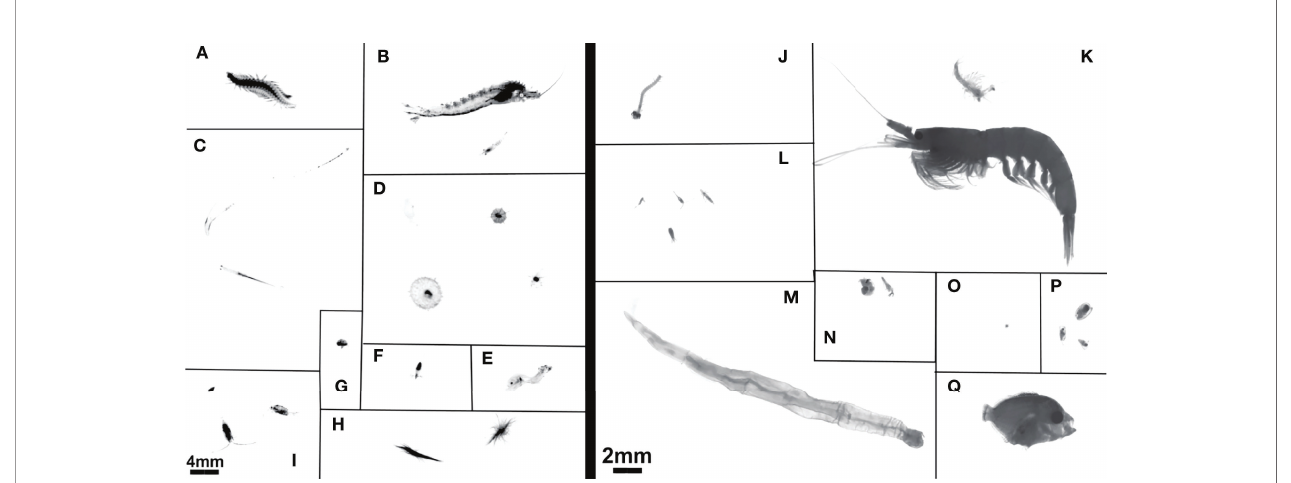
FIGURE 1 | Example images from (A – I) the UVP and (J – Q) MOCNESS. UVP images have 4mm scale bar in bottom left. MOCNESS images use 2mm scale bar in bottom right. UVP images are (A) Annelida, (B) Shrimp-like Crustacea, (C) Chaetognatha, (D) Rhizaria, (E) Actinopterygii, (F) Mollusca, (G) Ostracoda, (H) Trichodesmium, (I) Copepoda. MOCNESS images are (J) Annelida, (K) Shrimp-like Crustacea, (L) Copepoda, (M) Chaetognatha, (N) Mollusca, (O) Acantharea, (P) Ostracoda, (Q)